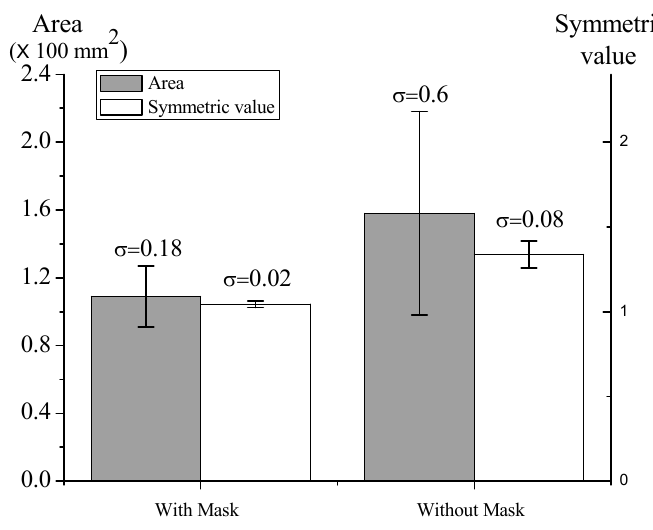
Figure 7. Particle deposition stability with and without mask. The pressure was 0.3 MPa; flow rate was 10 L/min; and distance was 10 mm. Data are shown with mean ± SD ( n = 3).